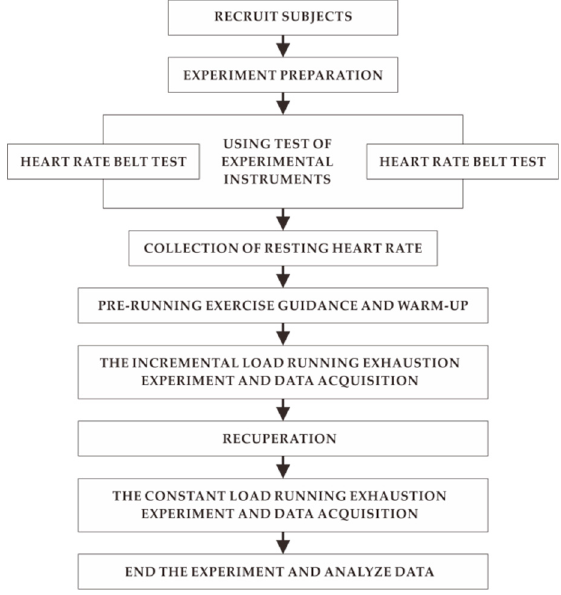
Figure 2. Experimental progress.